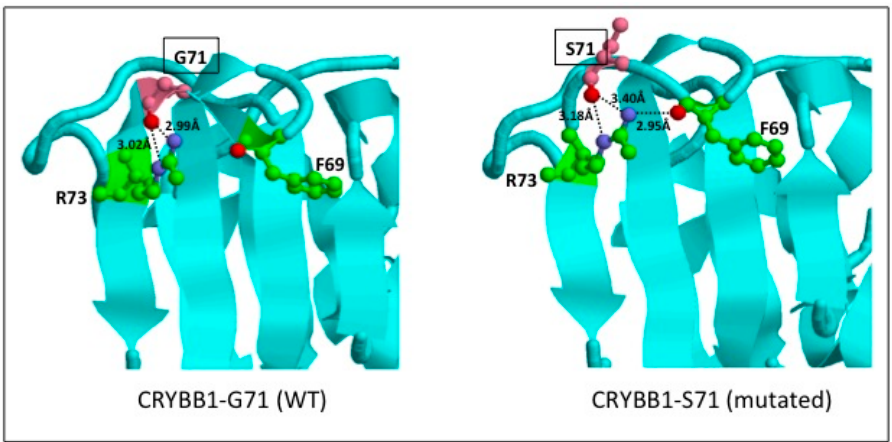
Figure 2. Structure of a CRYBB1 monomer and predicted consequences of the CRYBB1 p.Gly71Ser mutation (left: wild type (WT), right: mutated). CRYBB1 structure (WT) is according to Protein Data Base (PDB) (1OKI), and corresponds to residues 54–236 of the protein, with 1.4 Å of resolution. Amino acid residues are numbered according to the CRYBB1 UniProtKB sequence (p53674). In the mutated model (CRYBB1 Ser71), a new H-bond interaction was predicted between oxygen atom (red) of Phe69 (green) and azote atom (purple) of Ser71 (pink) residues, as well as the loss of part of the β strand. For convenience, only one chain of the CRYBB1 homodimer is represented. H-bonds are shown in black dotted lines.